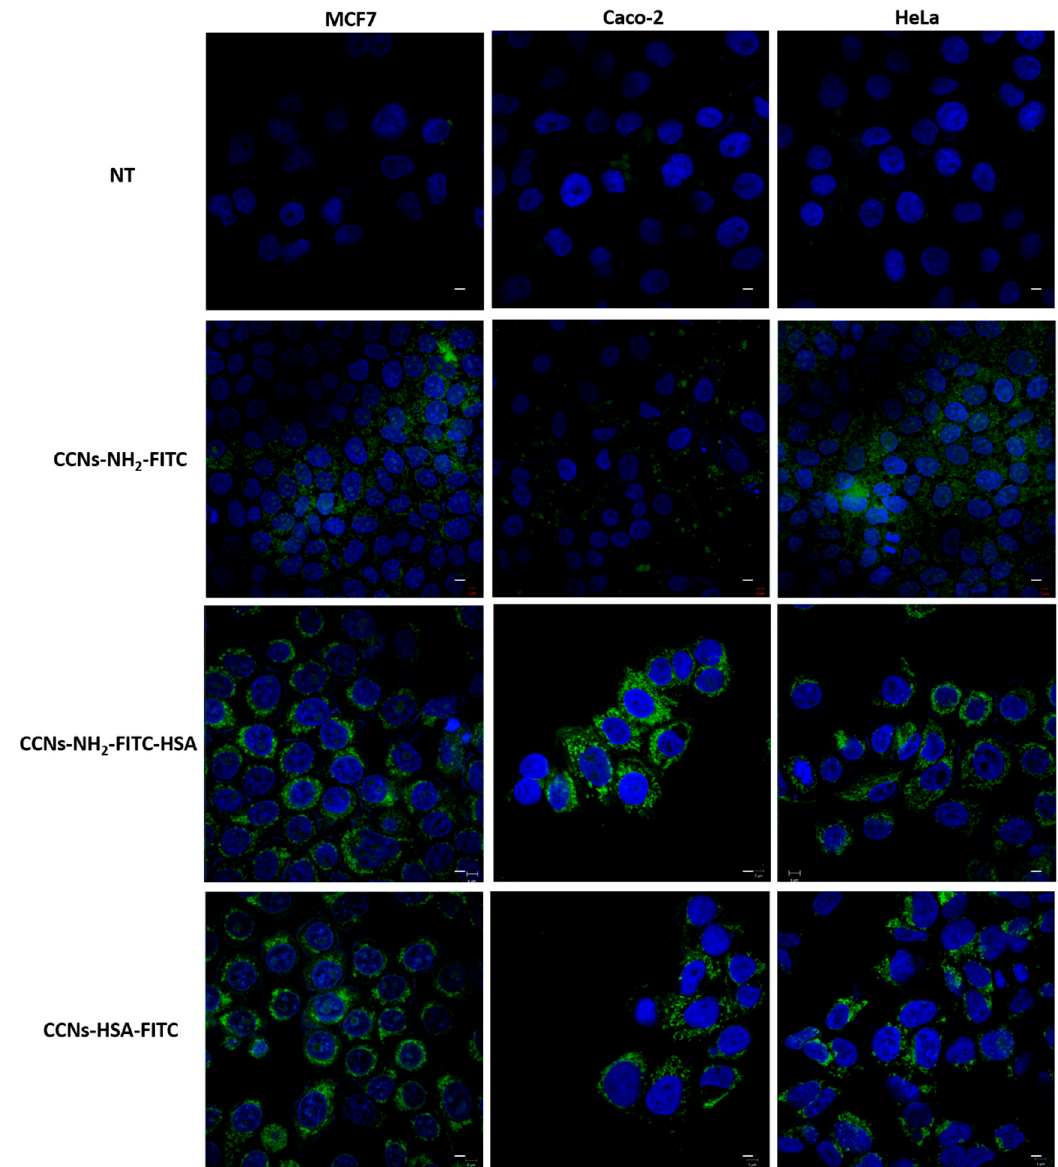
Figure 5. Confocal microscopy images evidencing cellular uptake of CCNs-FITC samples by MCF-7, HeLa and Caco-2 cells. The nucleus was stained by using Hoechst 33342 (blue) after cells fixation. A FITC filter responding to green fluorescence signals was employed to recognize the location of FITC conjugated CCNs: CCN-NH 2 -FITC, CCNs-NH 2 -FITC HSA and CCNs-HSA-FITC. Scale bar 5 µ